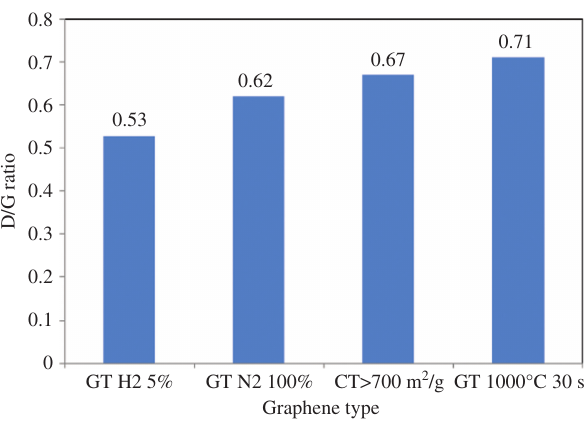
Figure 4 Raman spectra comparing the D/G ratio of graphene produced using four different methods (ratios compared using unsmoothed